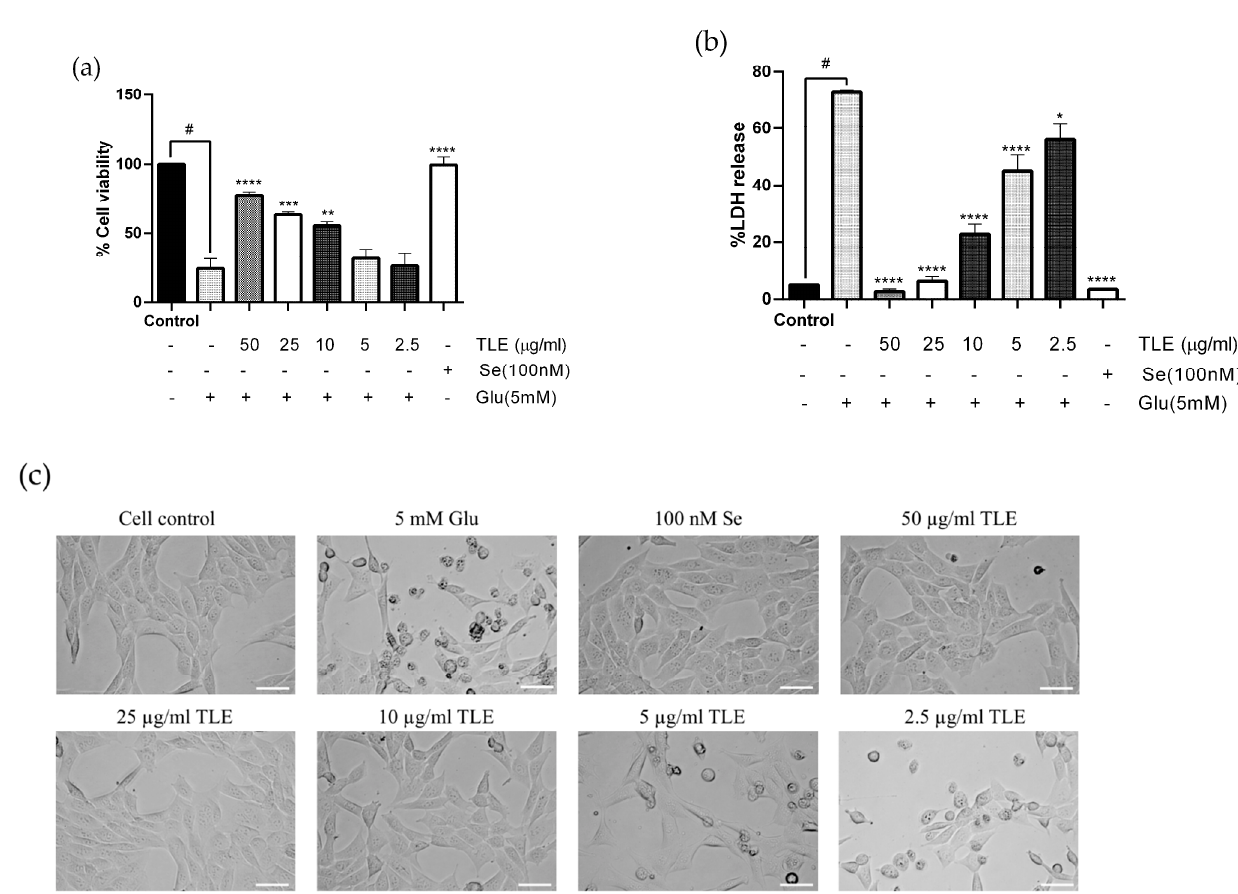
Figure 1. TLE attenuates glutamate-induced toxicity in HT-22 cells. The effect of TLE on glutamate-induced cytotoxicity in HT-22 was assessed by MTT assay and LDH assay. HT-22 cells (passage 12–15) were pre-treated with TLE at different concentrations (2.5–50 µ g/mL) and selenium as a positive control for 24 h, followed by 5 mM glutamate for 18 h. Bar graphs show the % cell viability ( a ) and % LDH release ( b ). The morphology of HT-22 cells was visualized under the inverted light microscope (scale bar is 50 µ m) ( c ). The data were collected from at least three independent experiments and the results are shown as mean SEM. * p value < 0.05, ** p value < 0.01, *** p value < 0.005, **** p value < 0.001 compared with glutamate ± treatment group, # p value < 0.001 compared with untreated